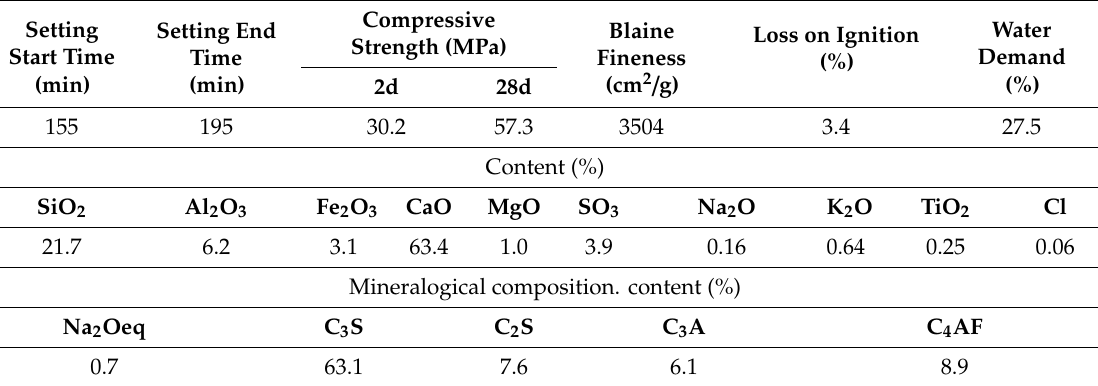
Table 1. Chemical composition and physical properties of the CEM I 42.5R